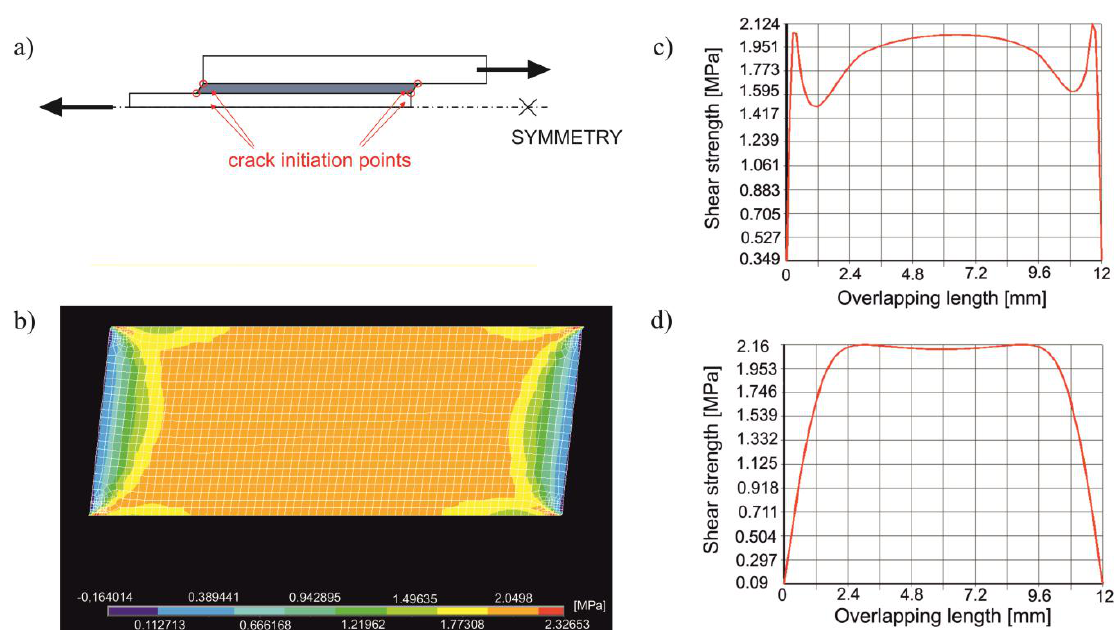
Fig. 2 Shear stress along the joint and crack initiation points: a) geometrical setup of loading; b) shear stress in adhesive layer; c) shear stress along the overlap length at substrate-adhesive interface; d) shear stress along the the overlap length at centre of adhesive layer